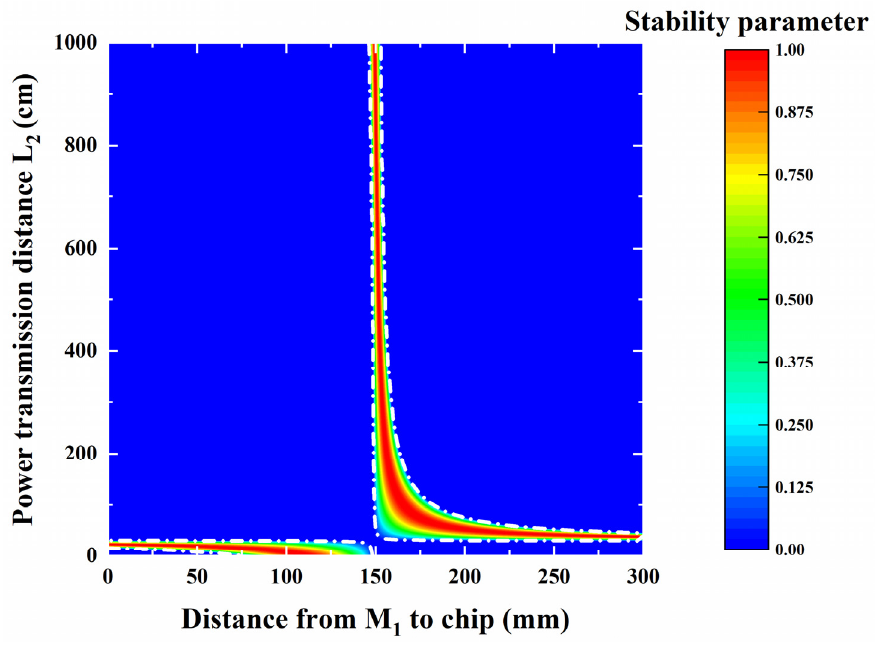
Figure 2. Influence of the cavity lengths L 1 and L 2 in VECSEL on the cavity stability. The area enclosed by the white dotted line is the working area for achieving a stable cavity.